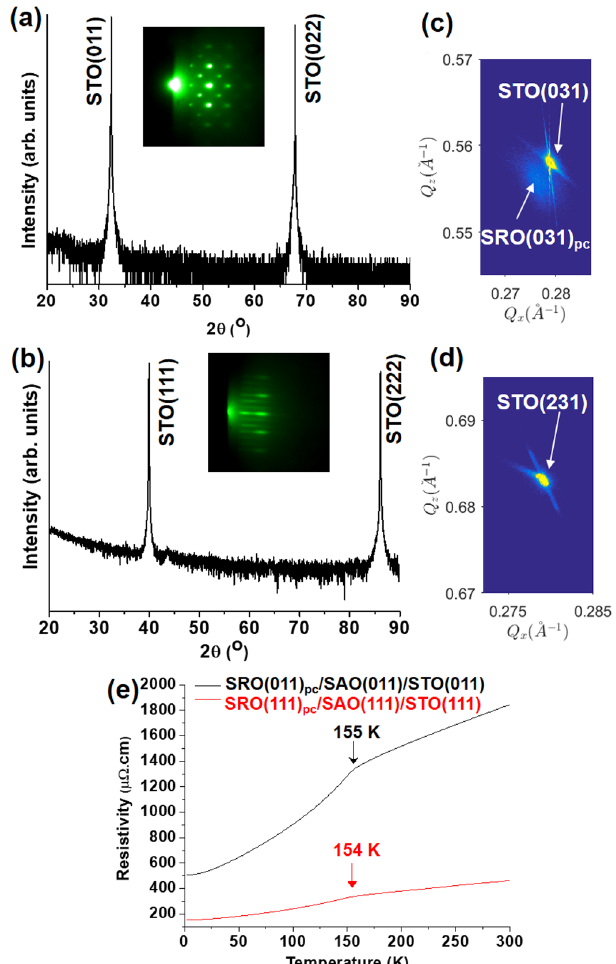
Figure 2. Identification of SRO films on sacrificial SAO layers. Panel ( a ) and ( b ) show that the XRD patterns of SRO(011) pc /SAO(011)/STO(011) and SRO(111) pc /SAO(111)/STO(111), respectively, could not resolve the reflections of SRO and SAO probably because the their reflections were close to those of STO and their intensities were much weaker than that of STO. The insets show clear spotty and streaky RHEED patterns, which were taken along the [01-1] direction of SRO(011) pc and SRO(111) pc films, respectively, indicating well- crystallized single phase SRO films. RSM around the STO(031) reflection ( c ) indicated that the SRO(011) pc film was not fully strained by the STO(011) substrate, while RSM around the STO(231) reflection ( d ) did not resolve the SRO(231) reflection of the SRO(111) pc film. The transport measurements ( e ) of SRO(011) pc /SAO(011)/ STO(011) and SRO(111) pc /SAO(111)/STO(111) exhibited characteristic behavior of SRO